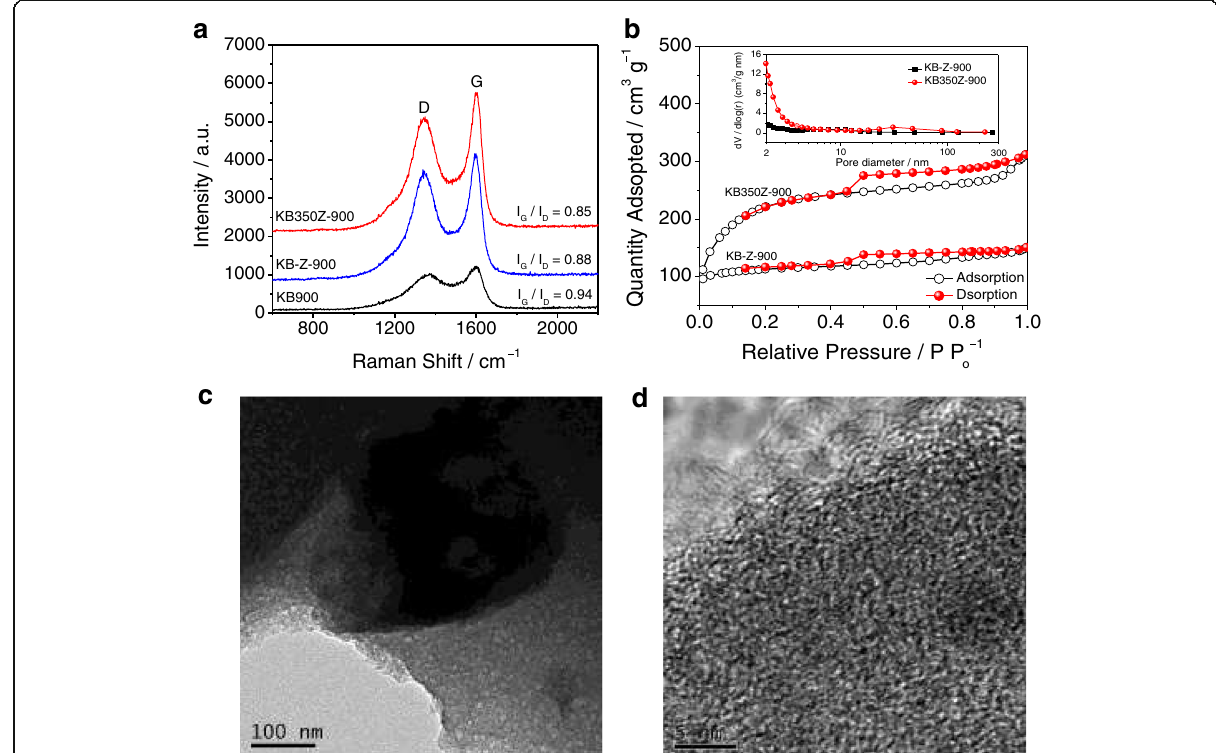
Fig. 1 a Raman spectra of KB900, KB-Z-900 and KB350Z-900. b Nitrogen adsorption-desorption isotherms and corresponding BJH pore-size distributions (inset) of KB-Z-900 and KB350Z-900. c Low-resolution and d high-resolution transmission electron microscopy images of